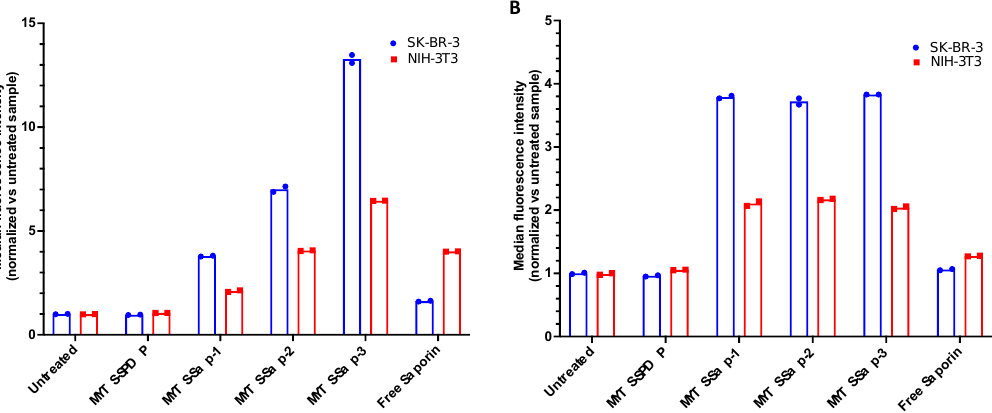
Figure 3. Cellular uptake of fluorescently labelled MYTS-Sap-1, MYTS-Sap-2 and MYTS-Sap-3 as evaluated by flow cytometry, with the incubation of an ( A ) equal MYTS concentration of 10 µg/mL or ( B ) an equivalent concentration of Saporin (5.4 nM) for 3 h. In both cases, free Saporin was used at the highest Saporin concentration tested (the one found in MYTS-Sap-3 equal to 22.2 nM and 5.4 nM, respectively).